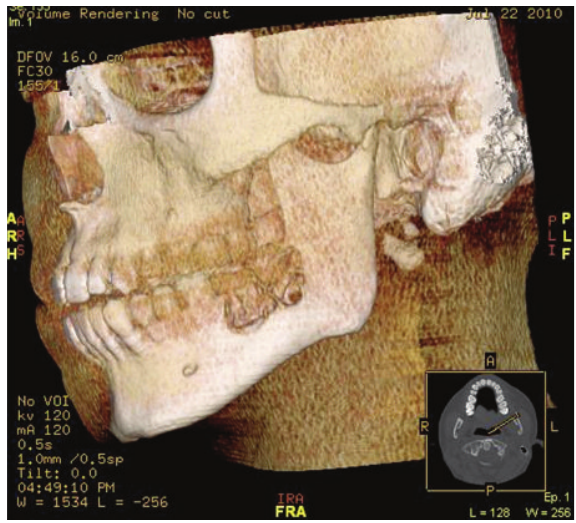
Figure 1: 3D reconstruction of left body/ramus mandibular brown